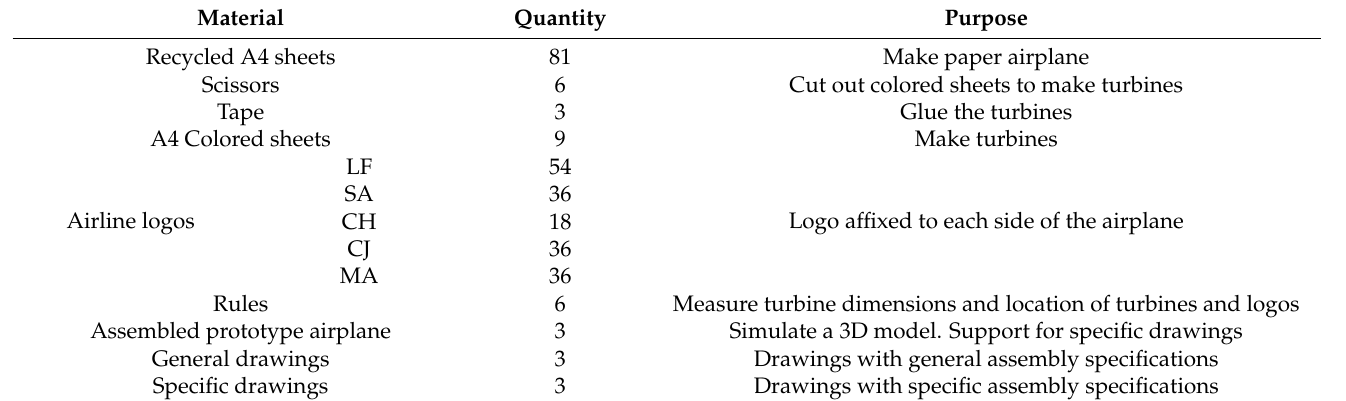
Table 5. Game materials with quantities for twenty-one